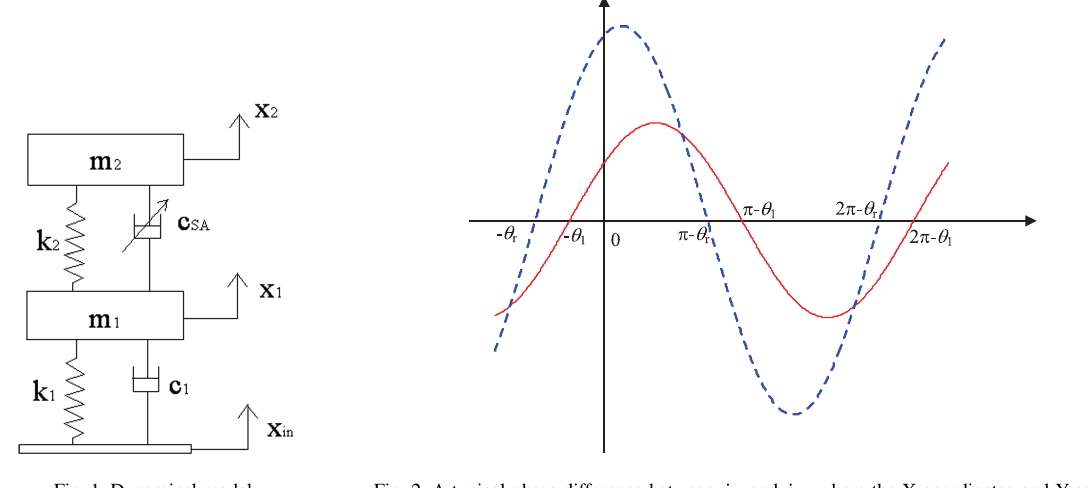
Fig. 1. Dynamical model. Fig. 2. A typical phase difference between ˙ x 1 and ˙ x r , where the X-coordinates and Y-coordi- nates are the phases and amplitudes of ˙ x 1 (the solid line) and ˙ x r (the dashed line)